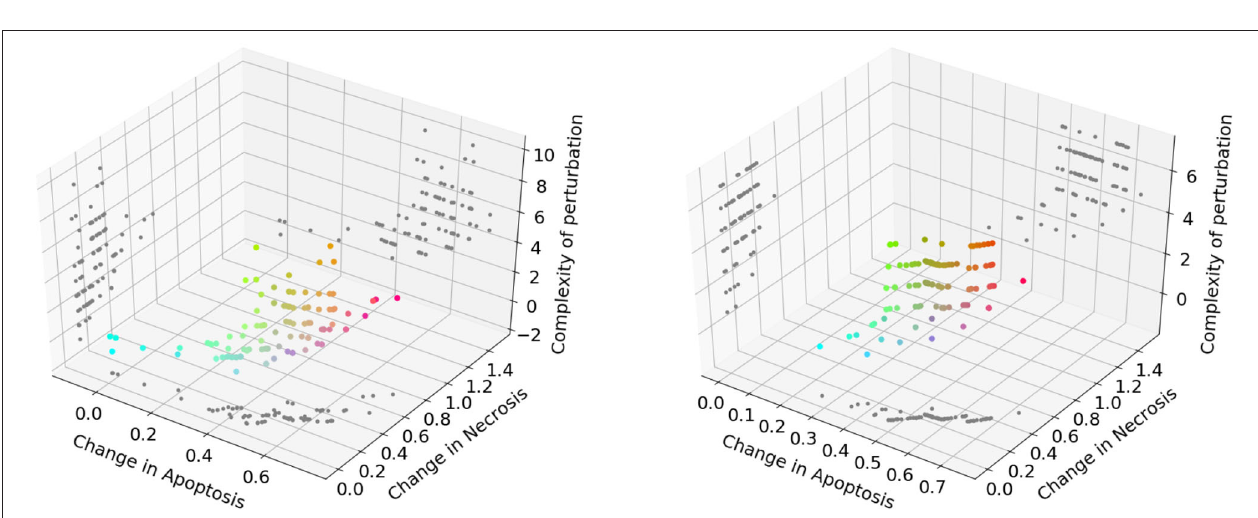
FIGURE 6 | Pareto dominant solutions obtained by NSGA-II using 3 objectives ( f ↑ apo , f ↓ nec , and f ↓ com ) in the PKA low condition (left) and PKA high condition (right) . Solutions’ color is represented by RGB triplets, according to their fitness values (i.e., red as change in apoptosis, green as change in necrosis and blue as complexity of the solution). Projections of the solutions on 2D planes are represented in